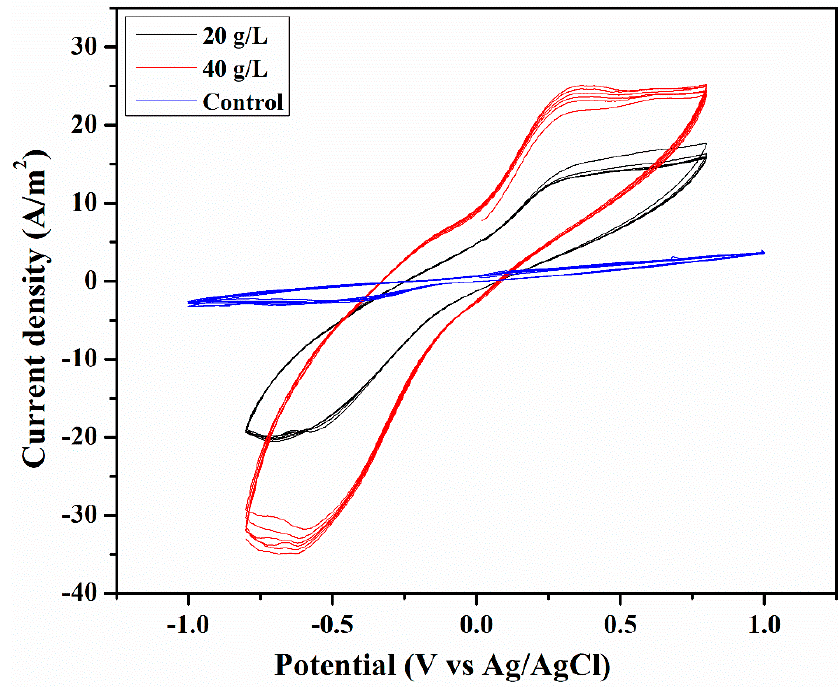
Figure 5. Cyclic voltammetry profile at different salinities and control MFC.